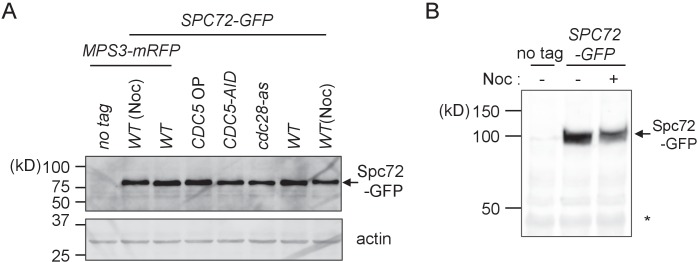
Spc72 protein level does not change at different cell cycle stages.(A) Logarithmically growing wild type (HPH399, HPH1394), CDC5-3mAID (HPH1380), PTEF1-CDC5∆53 (HPH1542), cdc28-as (HPH1212) cells with SPC72-GFP as well as no-tag control cells (HPH448) were grown in YPDS medium. IAA and 1NM-PP1 was added to cdc28-as and CDC5-3mAID cells respectively and incubated for 90 min prior to cell harvest (Figure 3—figure supplement 1). Wild type strains were incubated in YPDS medium containing nocodazole for 2.5 hr. Total cell extracts were analysed in a polyacrylamide gel followed by immunoblotting using anti-GFP antibody or anti-actin antibody. (B) Logarithmically growing SPC72-GFP cells (HPH399) were incubated in YPDS medium containing nocodazole for 2 hr. Total cell extracts were analysed in a polyacrylamide gel followed by immunoblotting using anti-GFP antibody. Comparable intensities of unspecific signal in immunoblotting (asterisk) indicate equal loading of samples.